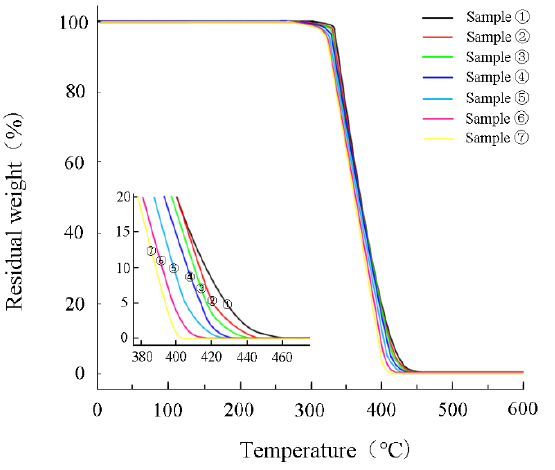
Figure 10. Thermogravimetric curves of coatings with different epoxy group molar ratios of E51:ED.